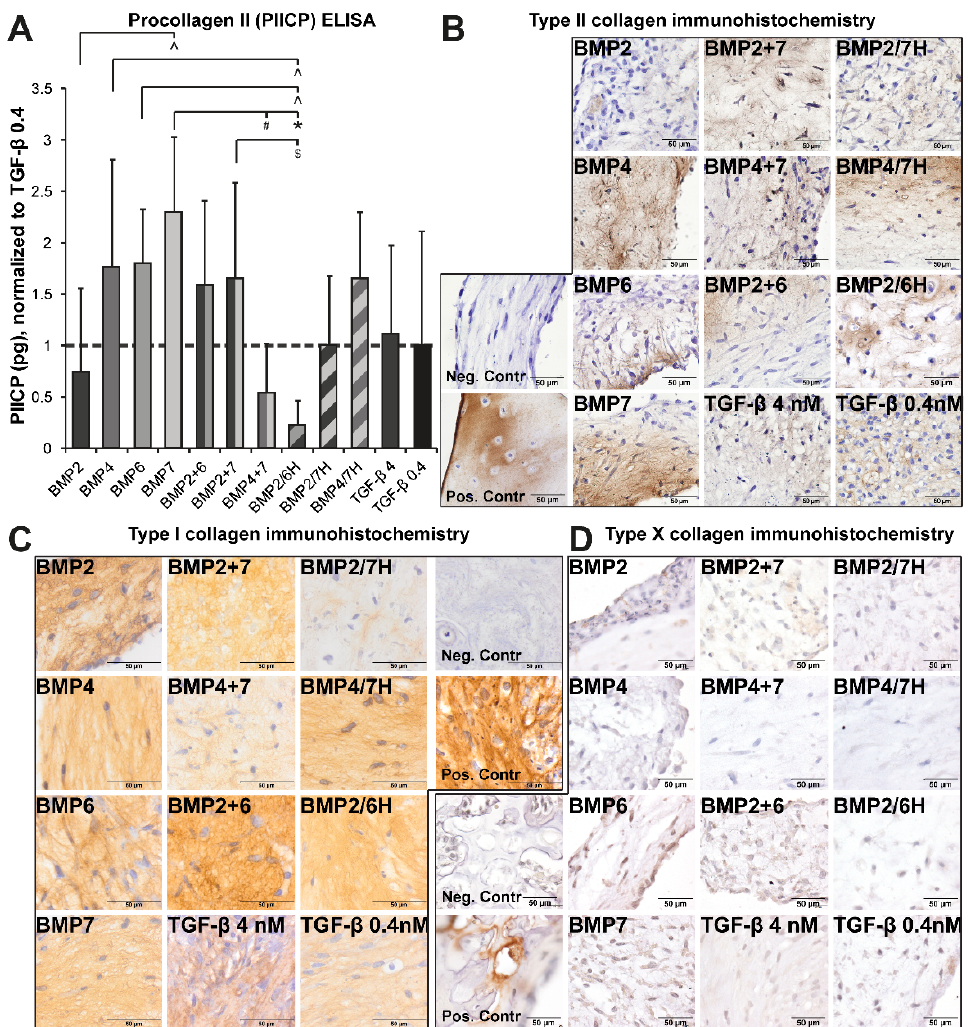
Figure 2. Human degenerated nucleus pulposus (NP) cells were cultured on type II